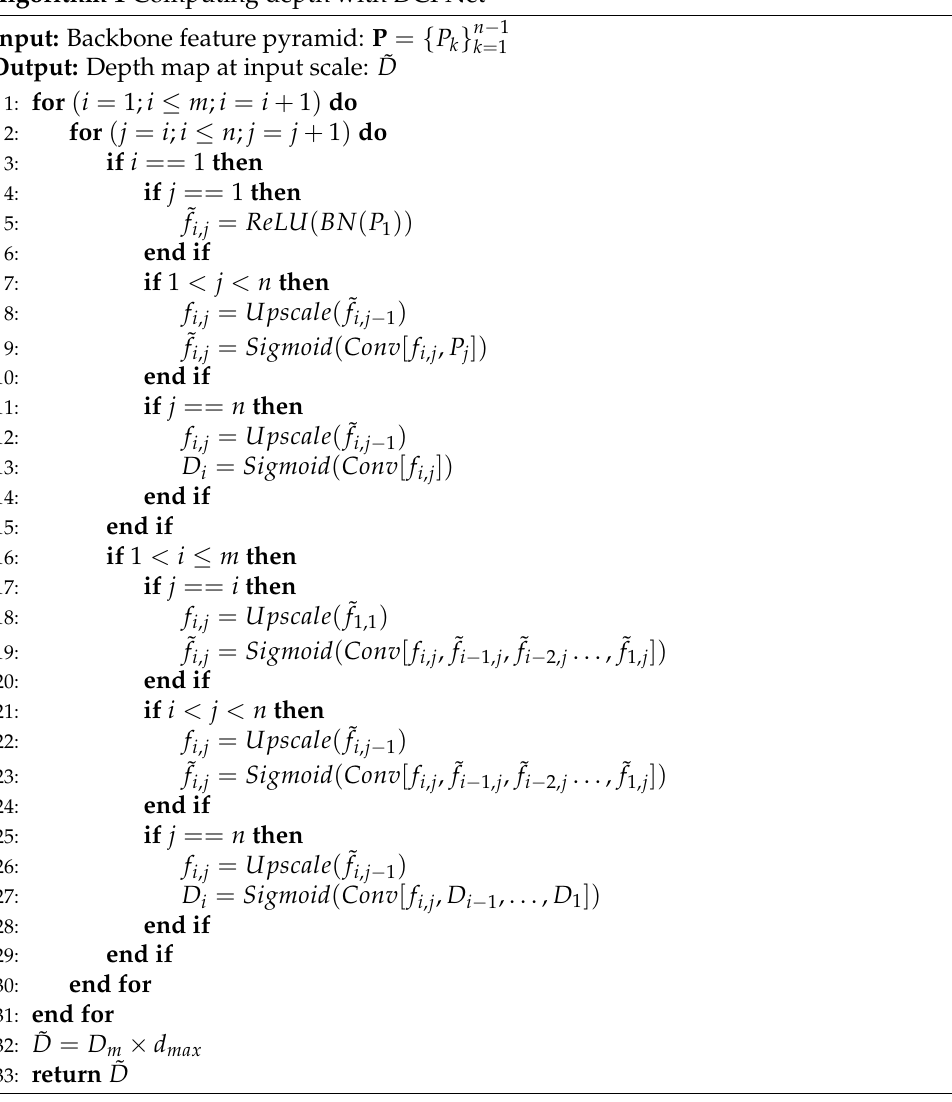
Algorithm 1 Computing depth with